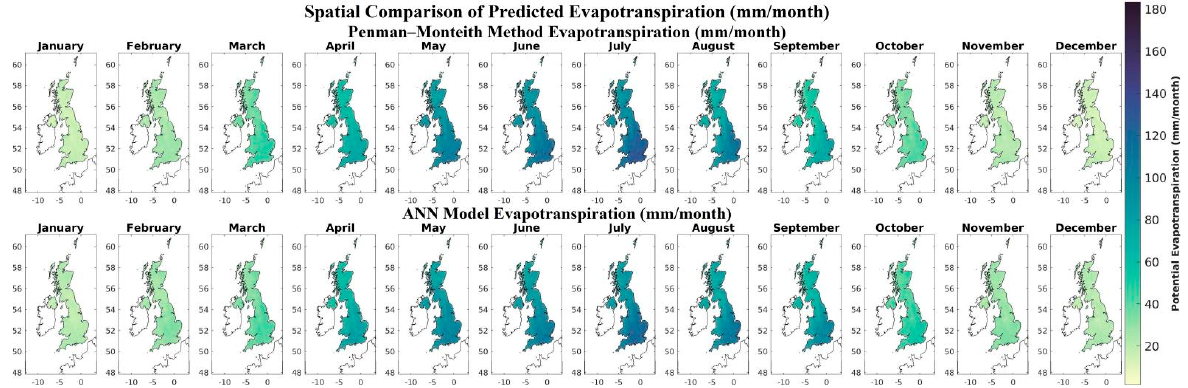
Figure 4. Monthly s patial visualization of PET using Penman–Monteith and ANN (prediction per ‐ Figure 4. Monthly spatial visualization of PET using Penman–Monteith and ANN (prediction formance).